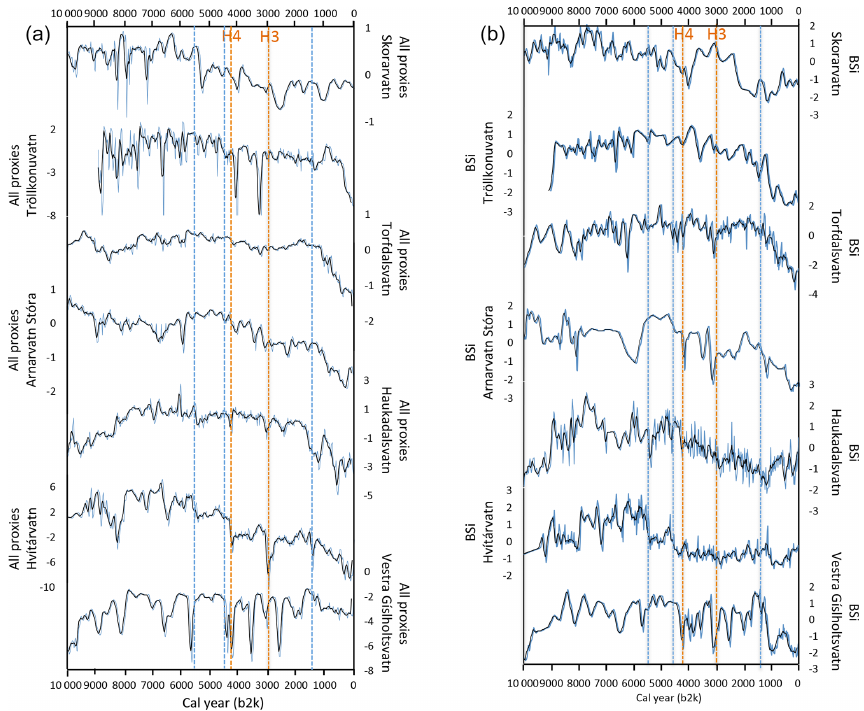
Figure 3. (a) Comparison of normalized composite proxy records of the seven lakes. Hekla 4 (H4; 4.2ka) and Hekla 3 (H3; 3.0ka) are marked with orange-colored, hatched lines. Blue hatched lines mark steps in the records at 5.5, 4.5, and 1.5ka. (b) Comparison of normalized composite BSi records of the seven lakes. Hekla 4 (H4; 4.2ka) and Hekla 3 (H3; 3.0ka) are marked with orange-colored, hatched lines. Blue hatched lines mark steps in the records at 5.5, 4.5, and 1.5ka. Table 2. Factor